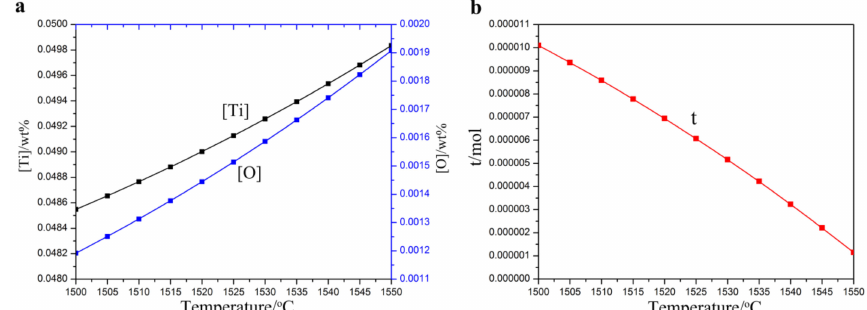
Figure 3. ( a ) The solid solubility of Ti, O and ( b ) molar fraction of precipitates in Ti0.05%-O0.002% series high-strength steel change as a function of temperature